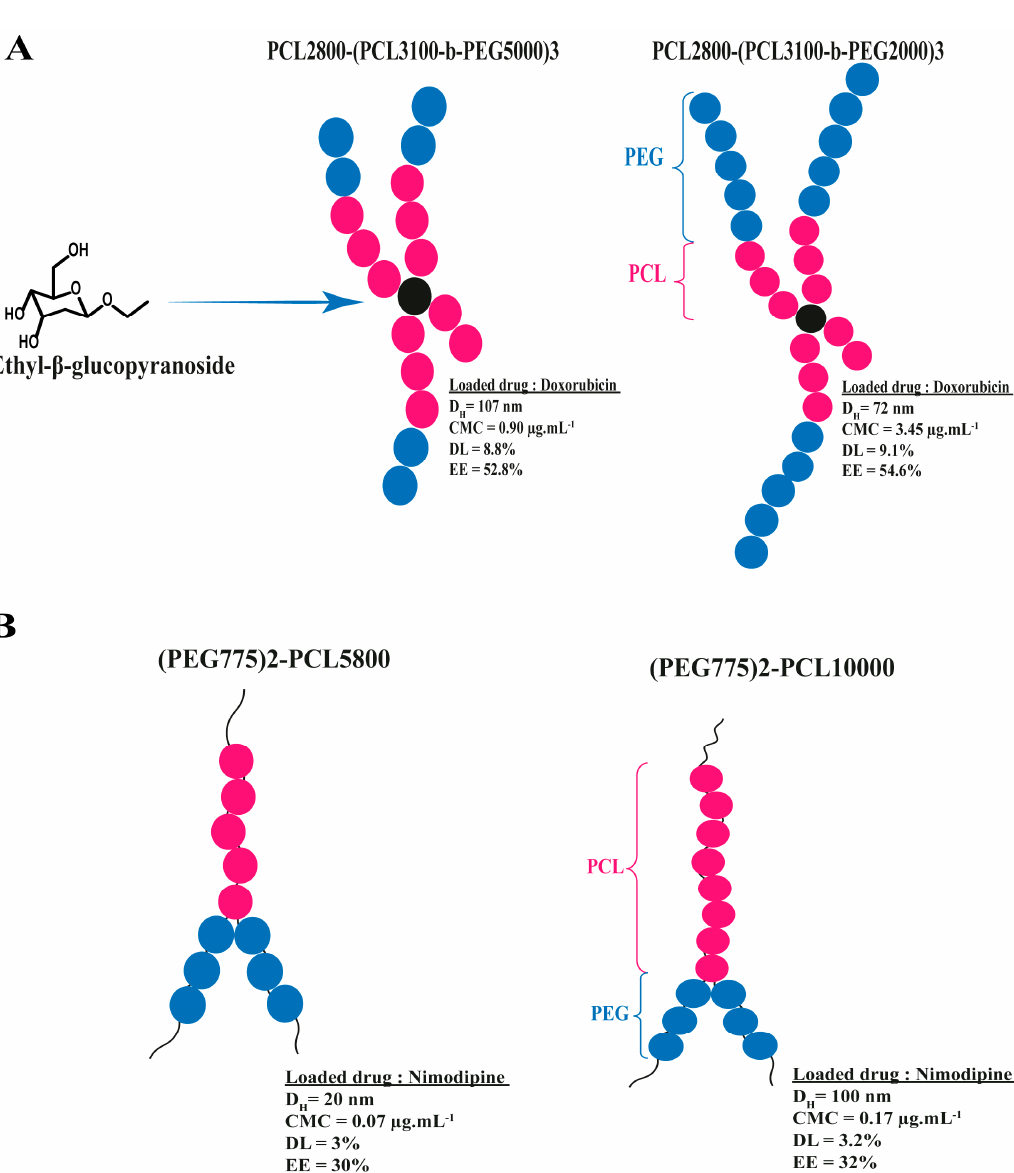
Figure 15. The effect of increasing the chain length on the nanoencapsulation parameters; for PCL(PCL-b-PEG) 3 ( A ), and in the case (PEG) 2 -PCL ( B ). PCL(PCL-b-PEG) 3 ( A ), and in the case (PEG) 2 -PCL ( B